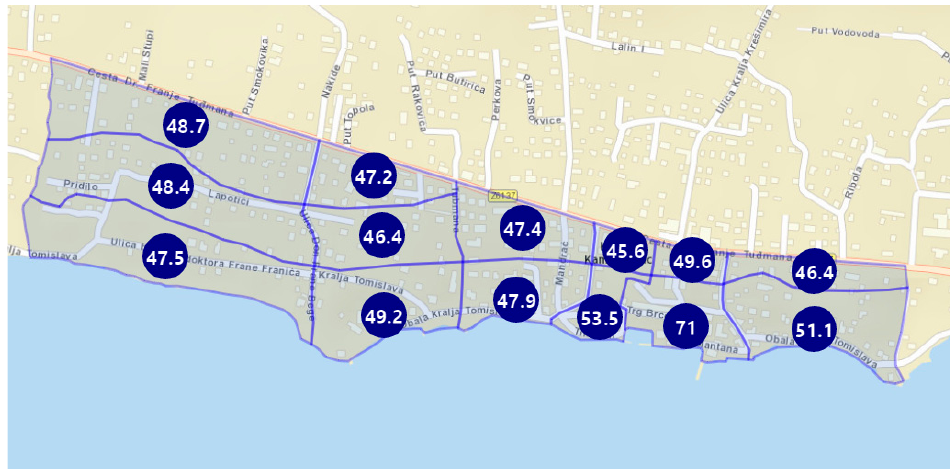
Figure 16. Results of risk analysis for seismic and flood hazard for Level 2 (Scenario S-F L2).